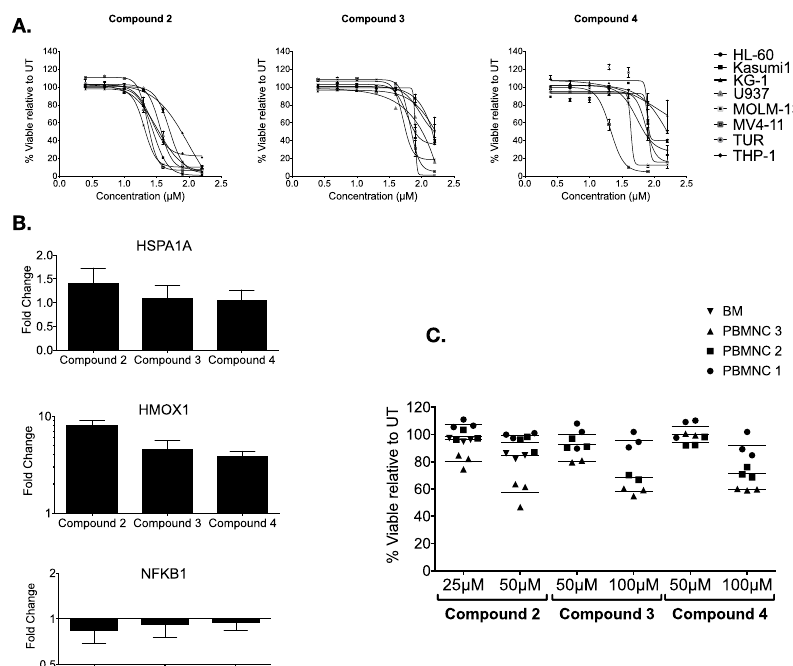
Figure 3. ( A ) Cytotoxic e ff ects of compounds 2 – 4 against eight acute myeloid leukemia (AML) cell lines. Viability of the cells after 48 h of treatment at di ff erent concentrations, from 1.25 to 160 µ M. ( B ) Compounds 2 – 4 induce heme oxygenase 1 (HMOX1) and HSPA1A and downregulate NF- κ B. Graphic B represents the fold changes of HSPA1A, HMOX1, and NFkB1A gene expression in MOLM-13 cells. Lines represent the mean for each specimen, with error bars representing the standard deviation (SD). The fold changes were calculated by the delta-delta Ct method. ( C ) The viability of normal cells after treatment with 2 , 3 , and 4 . Bone marrow and peripheral blood mononuclear cells were isolated from blood purchased form the New York Blood Center, and treated for 48 h with 25 µ M or 50 µ M of compound 2 , and 50 µ M or 100 µ M of compounds 3 or 4 . The average viability was evaluated by annexin V and 7AAD staining using flow cytometry. Each line represents a distinct sample with viabilities calculated relative to an untreated control.